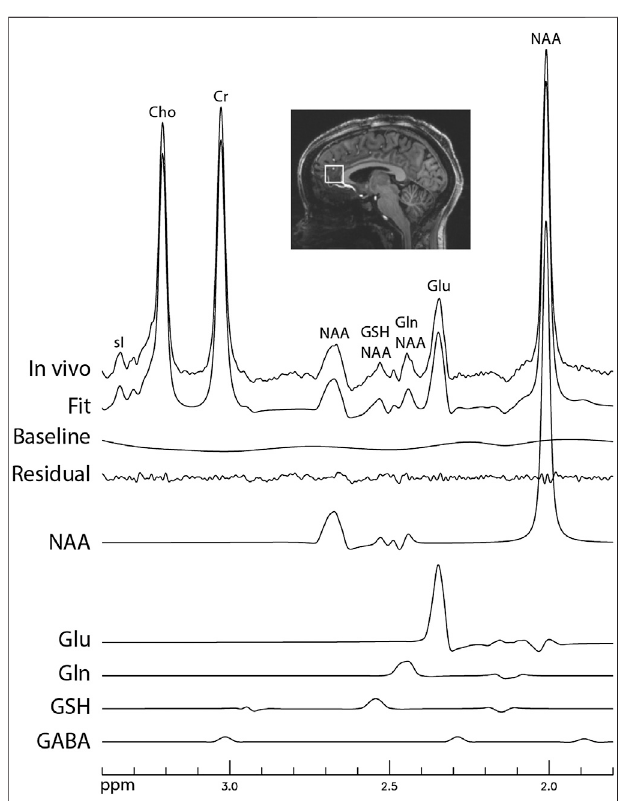
FIGURE 6 | In vivo spectrum acquired from the pregenual anterior cingulatecortexofahealthyparticipant. Nolinebroadeningwasapplied;